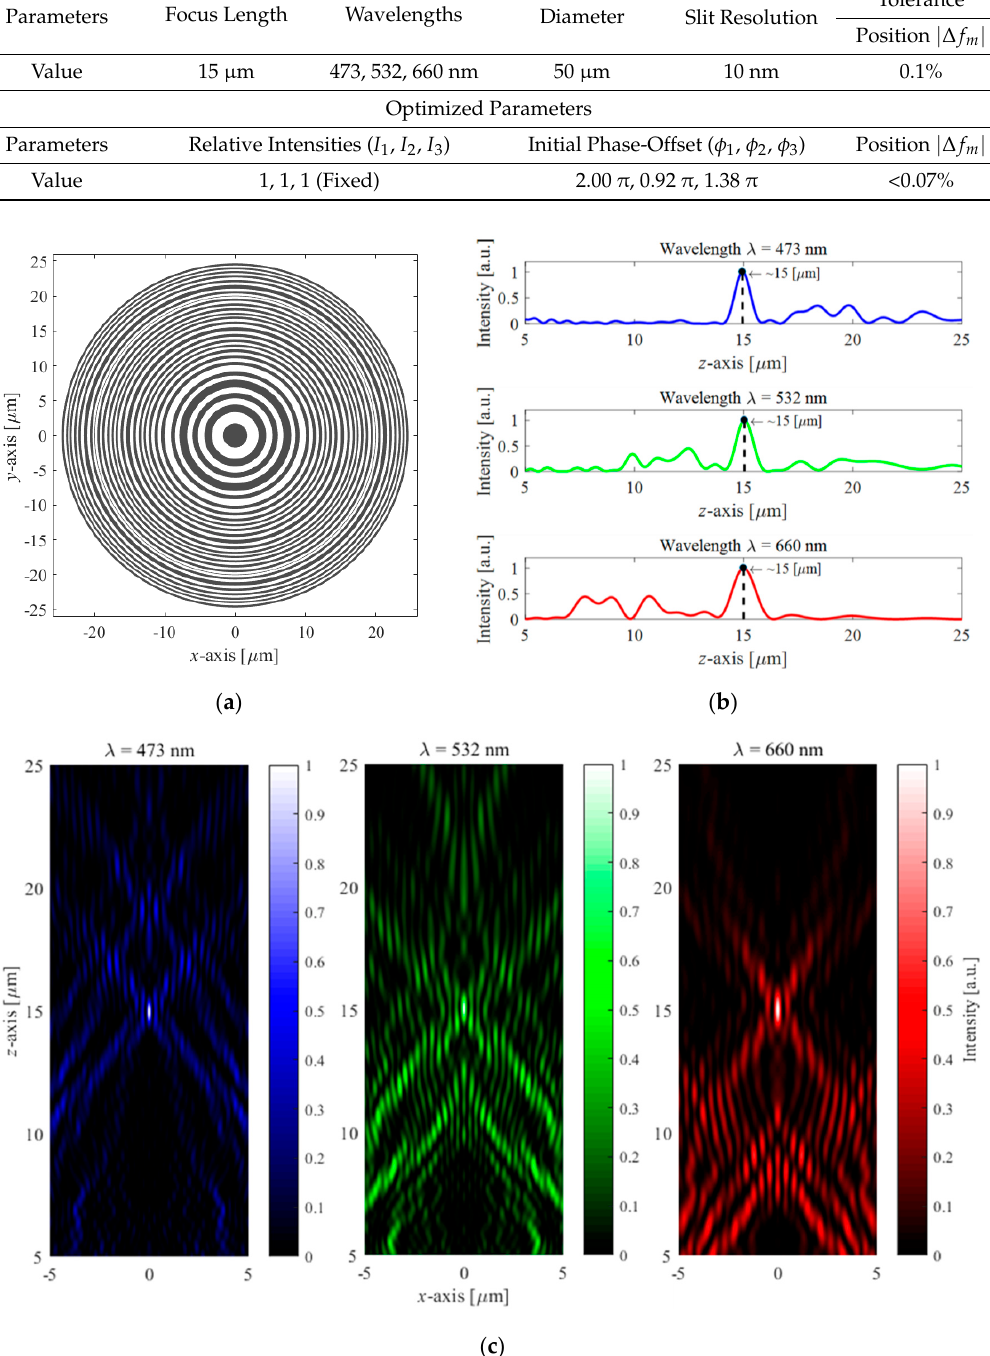
Figure 6. Simulation results for the multi-chromatic mono-focal MFZP specified in Table 2: ( a ) Shape of the calculated MFZP pattern. ( b ) Calculated intensity profiles on the center axis of the MFZP, i.e., the z -axis, for RGB beams. ( c ) Calculated intensity pattern formed through the MFZP for RGB beams.